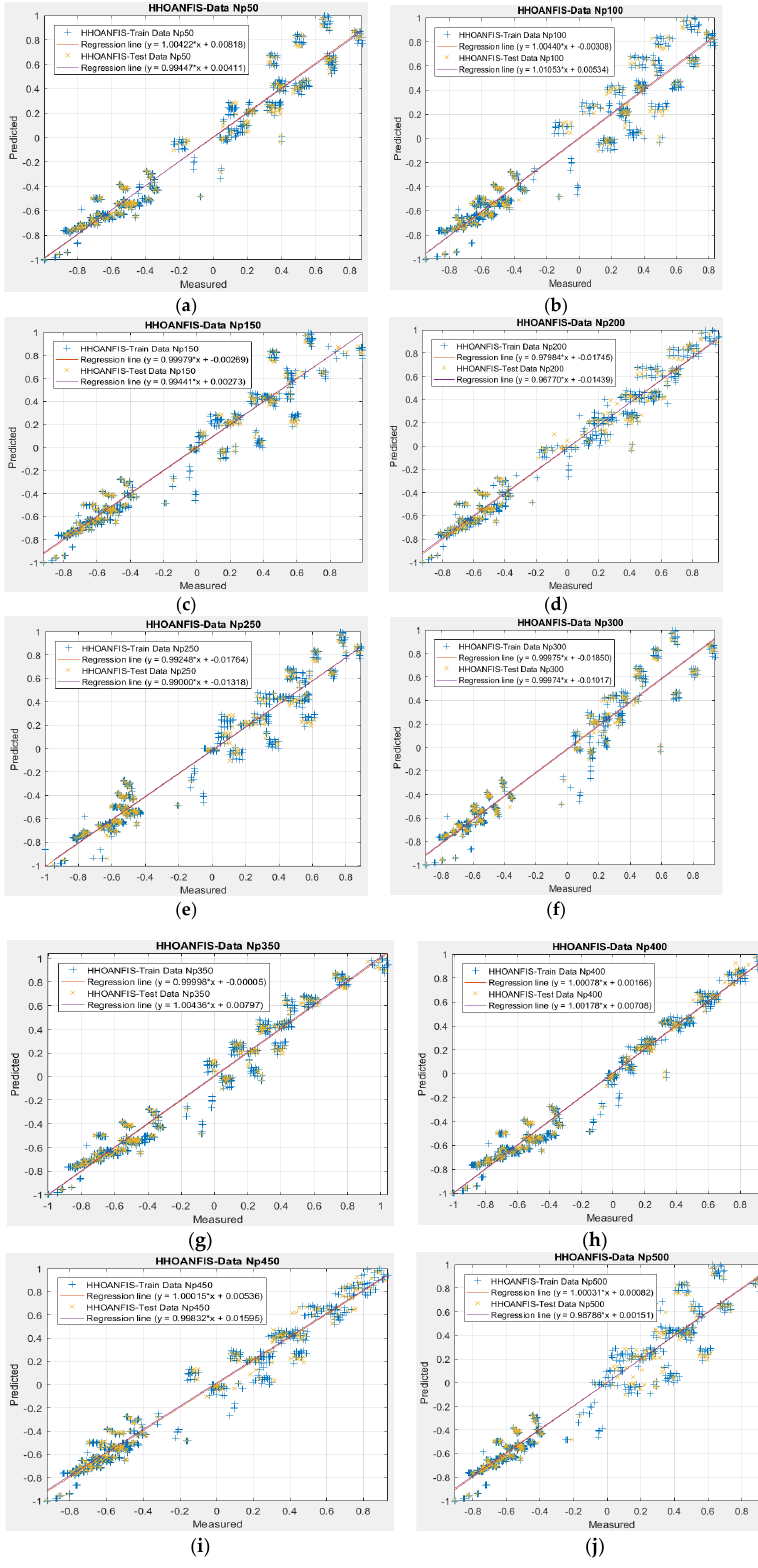
Figure 5. The accuracy of training and testing dataset performance of HHO − ANFIS in the best fit optimization structure. ( a ) HHO − ANFIS Np = 50. ( b ) HHO − ANFIS Np = 100. ( c ) HHOANFIS Np = 150. ( d ) HHO − ANFIS Np = 200. ( e ) HHO − ANFIS Np = 250. ( f ) HHO − ANFIS Np = 300. ( g ) HHO − ANFIS Np = 350. ( h ) HHO − ANFIS Np = 400. ( i ) HHO − ANFIS Np = 450. ( j ) HHO − ANFIS Np = 500.